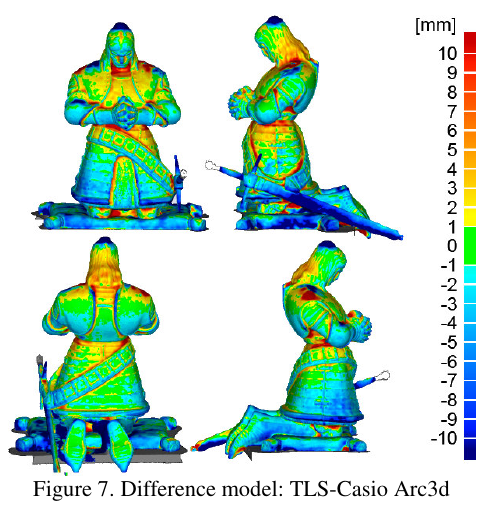
Figure 7. Difference model: TLS-Casio Arc3d